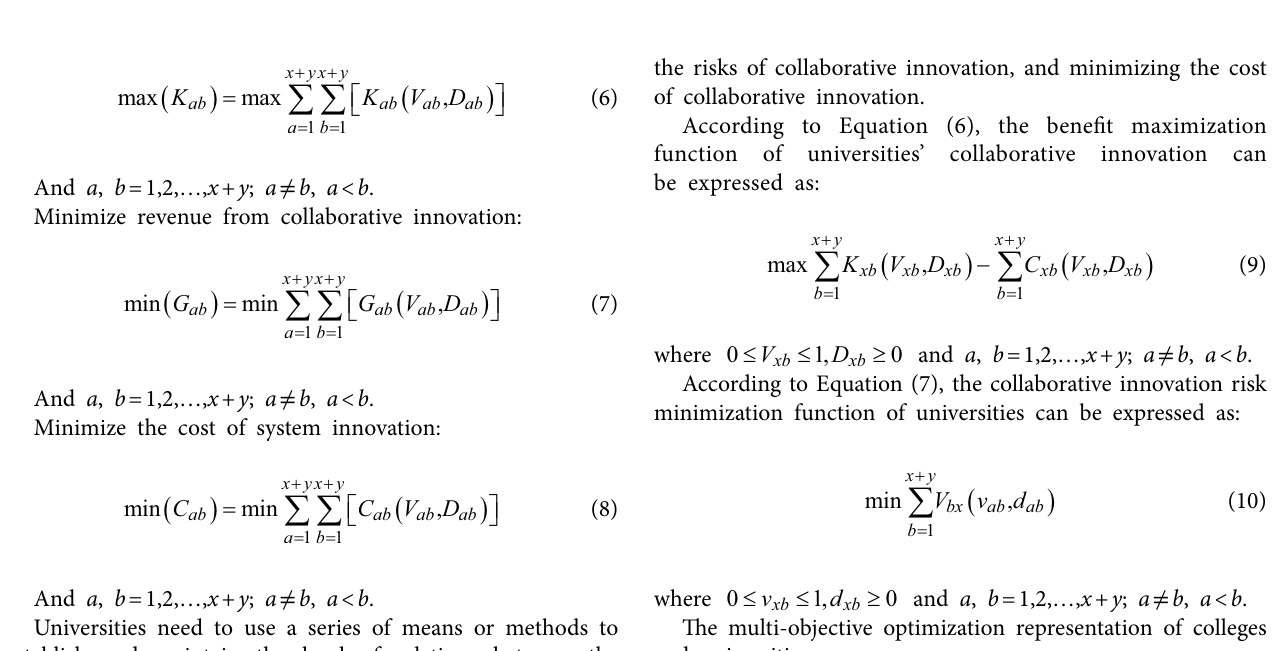
FIGURE 2 | Diagram of collaborative psychology management innovation framework in colleges and